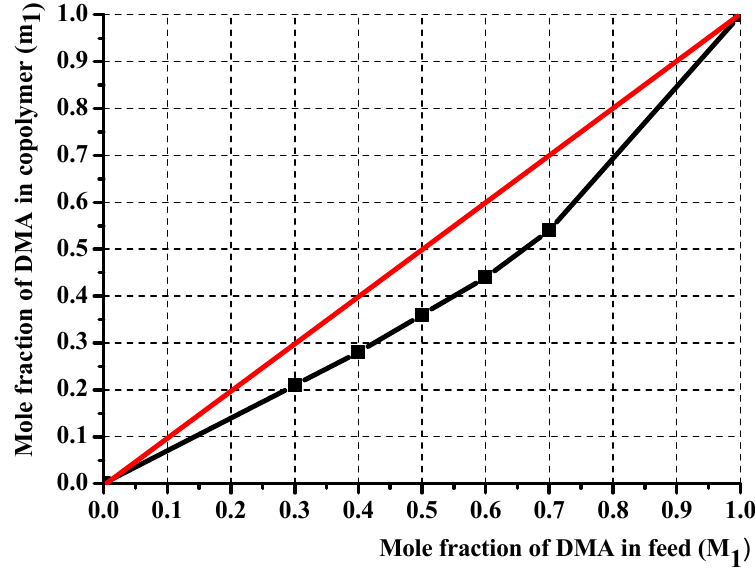
Figure 4. Composition of poly(DMA ‐ co ‐ AAc) copolymer.